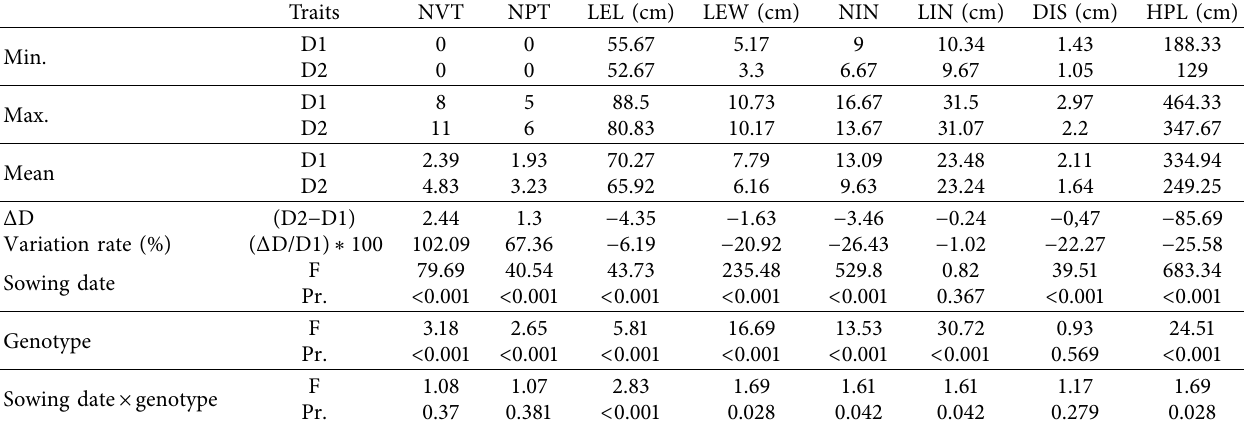
Table 2: Results of the analysis of variance of vegetative morphological